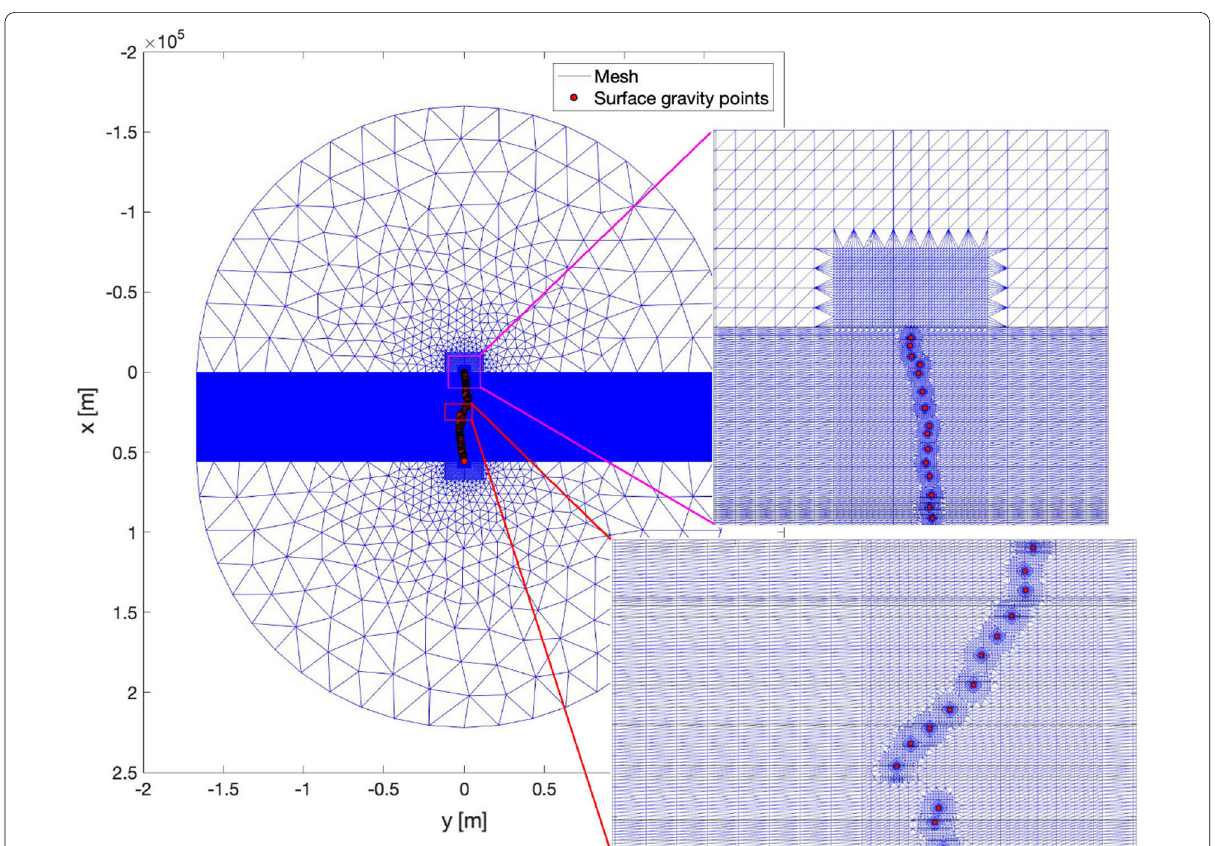
Fig. 6 Graphical representation of the numerical mesh used for the density-dependent gravity correction computation. The digital elevation model (either swissALTI3D or SRTM) depending on the required resolution) is sampled at each mesh node and subsequently used for the computations. The resolution of this static mesh is higher (10 m) in the vicinity of the gravity measurement points (red circles) and along the reference model line (including the original GBT track), while it decreases with increasing distance from this central zone. The two insets show the varying spatial resolution for two particular areas, along the reference model line and at around the northern tunnel portal. The thin horizontal black lines in the two insets mark the boundaries between geological units at the surface digitised from the GBT geological profile, which were included as a line of nodes in the mesh. It is of fundamental importance that the mesh respects these boundaries, allowing for a correct and consistent density mapping from the 3D structures to the 2D profile, for the computation of the terrain-adaptation